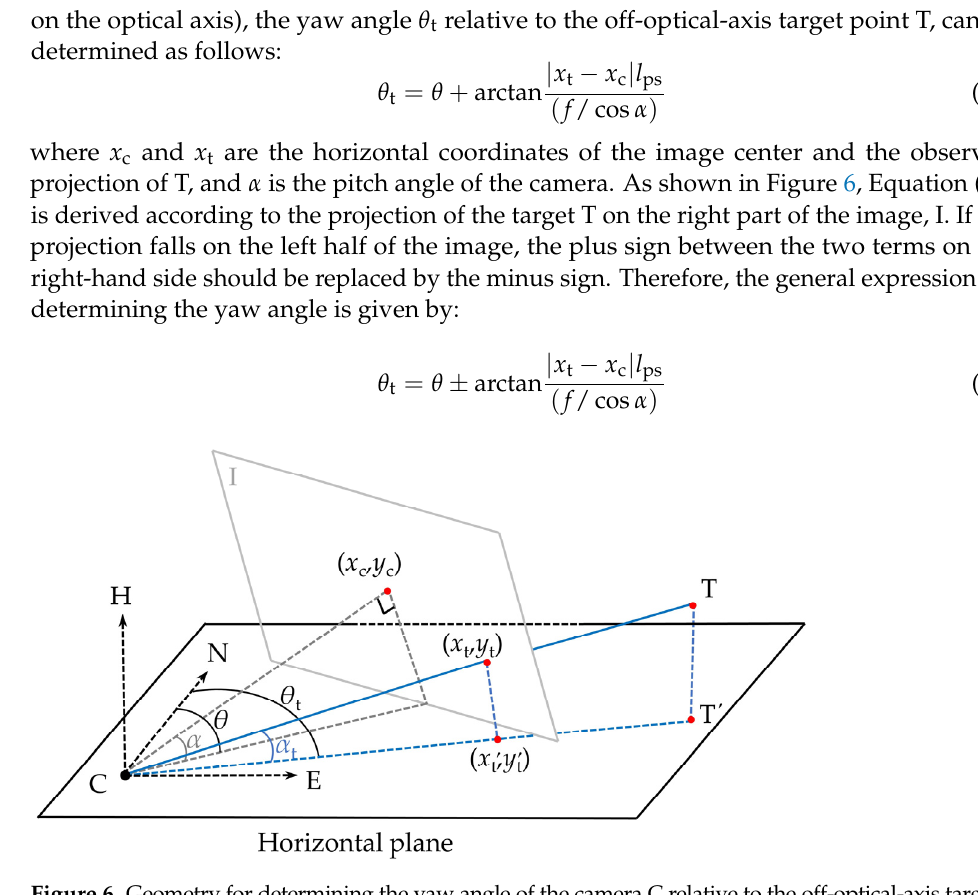
Figure 6. Geometry for determining the yaw angle of the camera C relative to the off-optical-axis